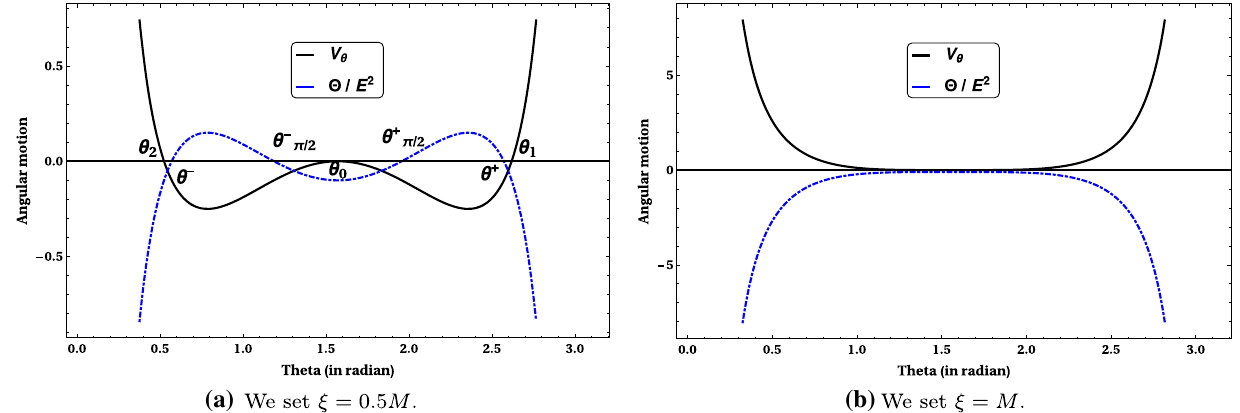
Fig. 7 The momentum and potential associated with the angular motion of a massless particle in the Kerr–Newman spacetime is depicted with negative Carter constant, i.e., with λ = − 0 . 1 M 2 and rotation parameter: a =